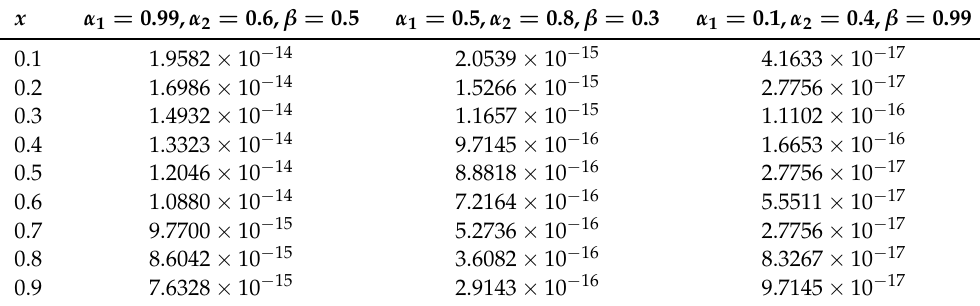
for Example 2. 20